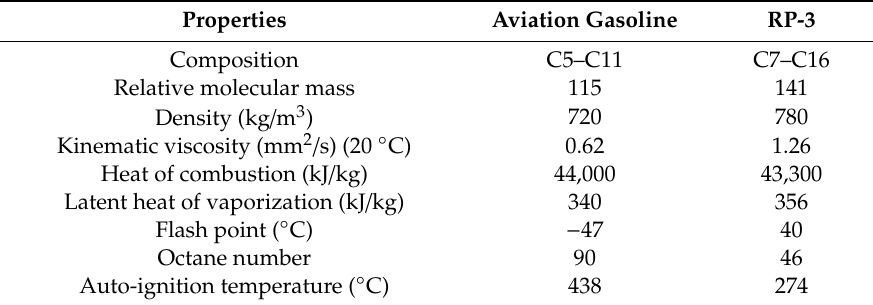
Table 1. Property comparisons of aviation gasoline and